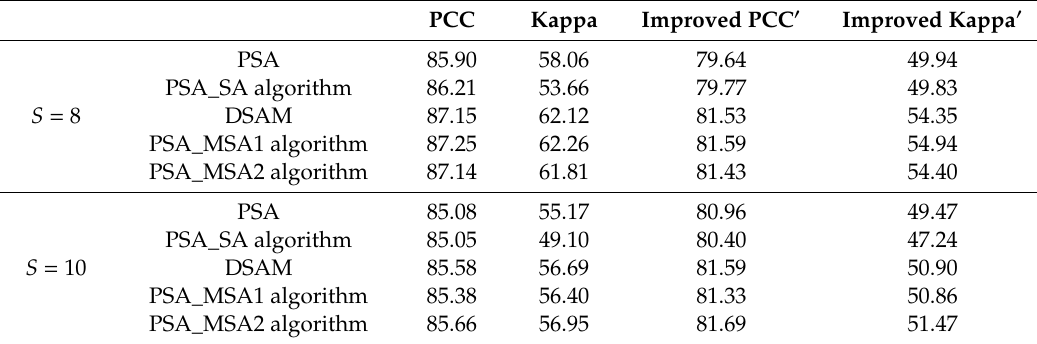
Table 7. Accuracy (%) results of different models for the real land image.